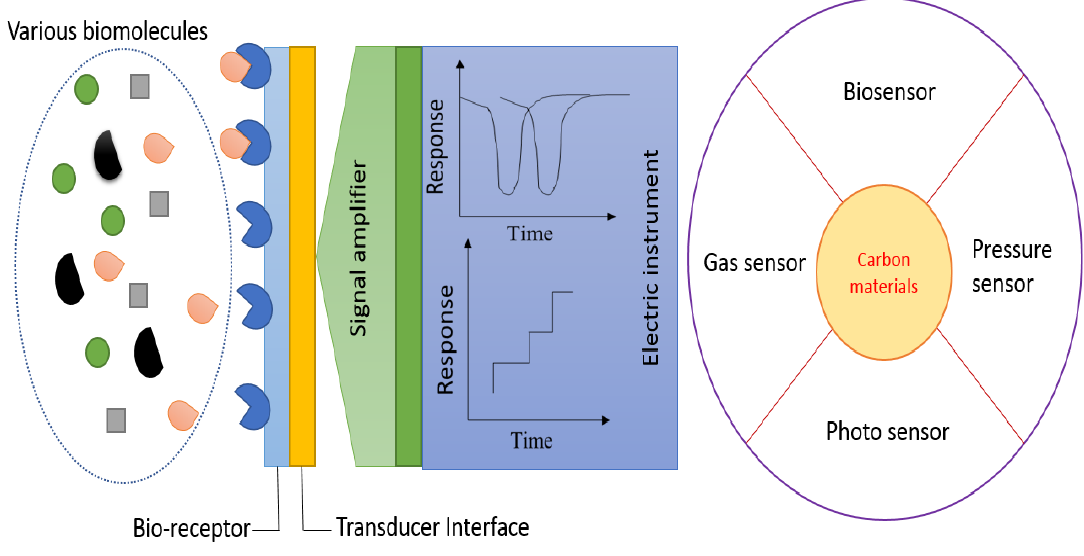
Figure 8. General layout of a typical biosensors system, and use of carbon materials in various sensors applications.